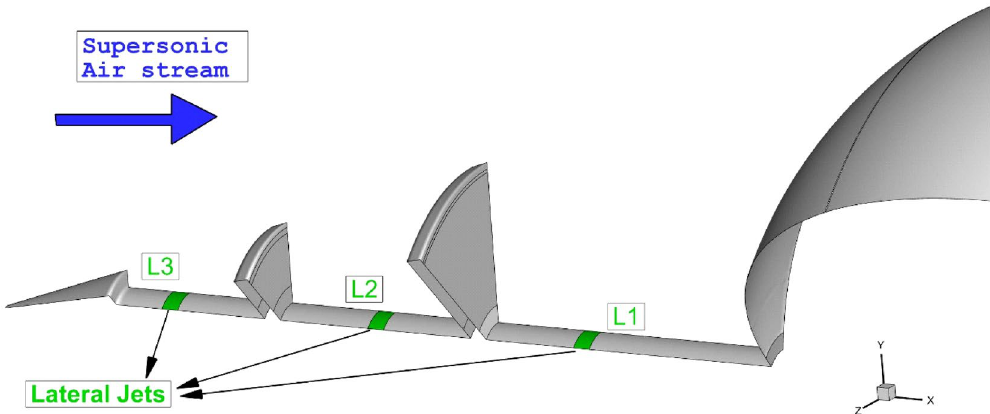
Figure 1. Selected model with proposed injection